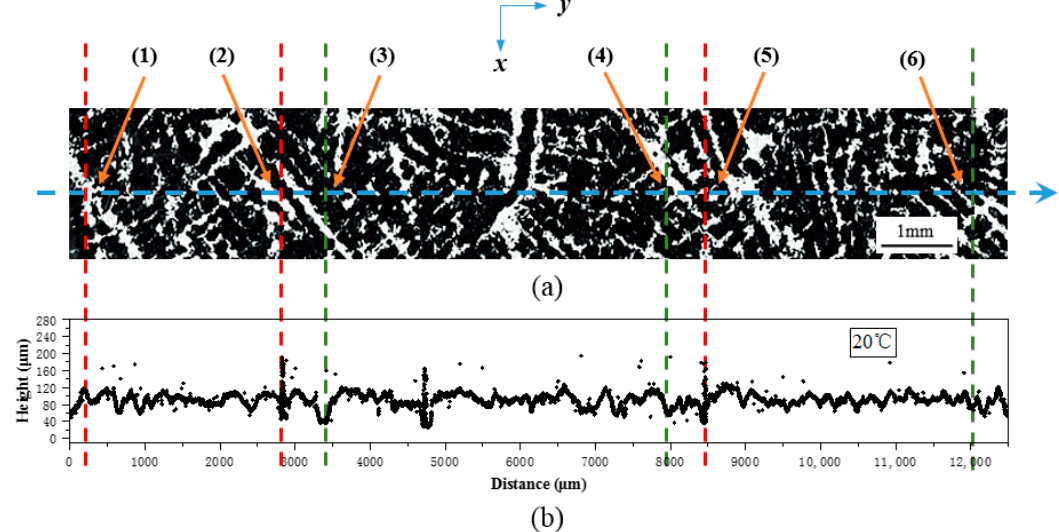
Figure 9. Correlation between the segregating element contents and the etched surface heights at F position in the inner curve of Scheme 20 °C along horizontal dashed arrow corresponds to the same arrow in Figure 3: ( a ) macrostructure marked in the red rectangular area in Figure 4 photographed by a SELP1650 digital camera; ( b ) etched surface height ( h es ) along horizontal dashed arrow in Figure 9a. (1), (2) and (5) points have a relative maximum value of height. (3), (4) and (6) points have a relative minimum value of height.